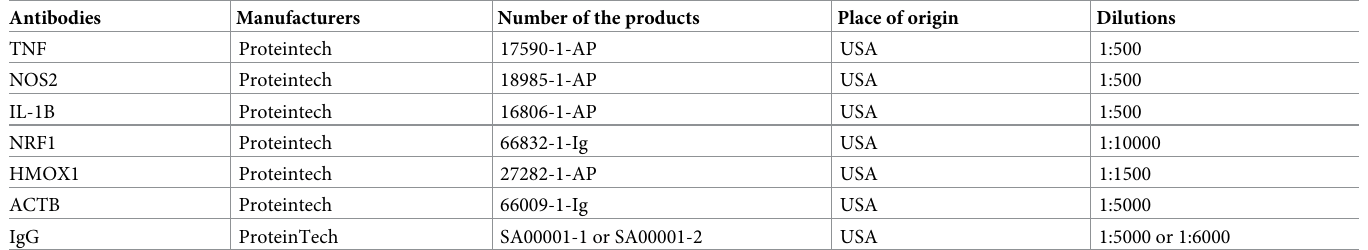
Table 3. Details of the antibodies against the proteins in western blot.